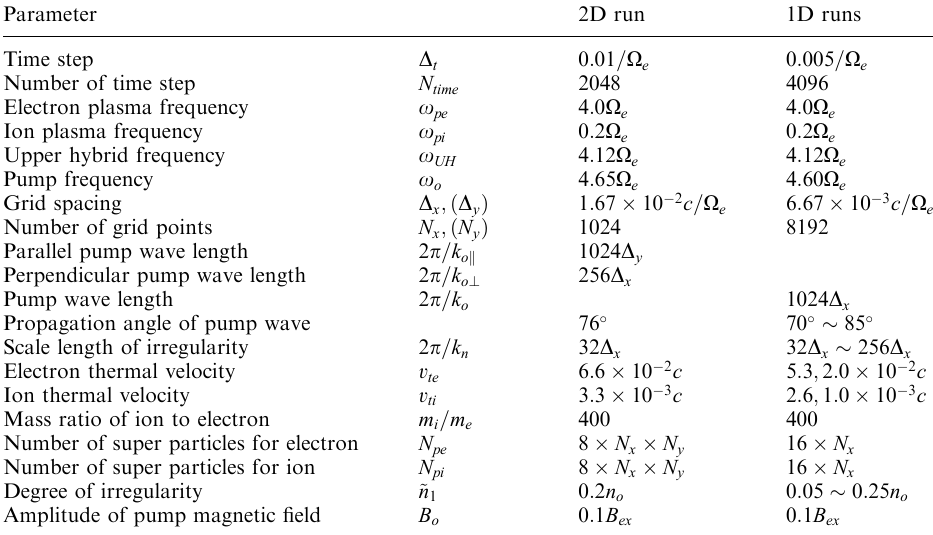
Table 1. Parameters for simu- lations Parameter 2D